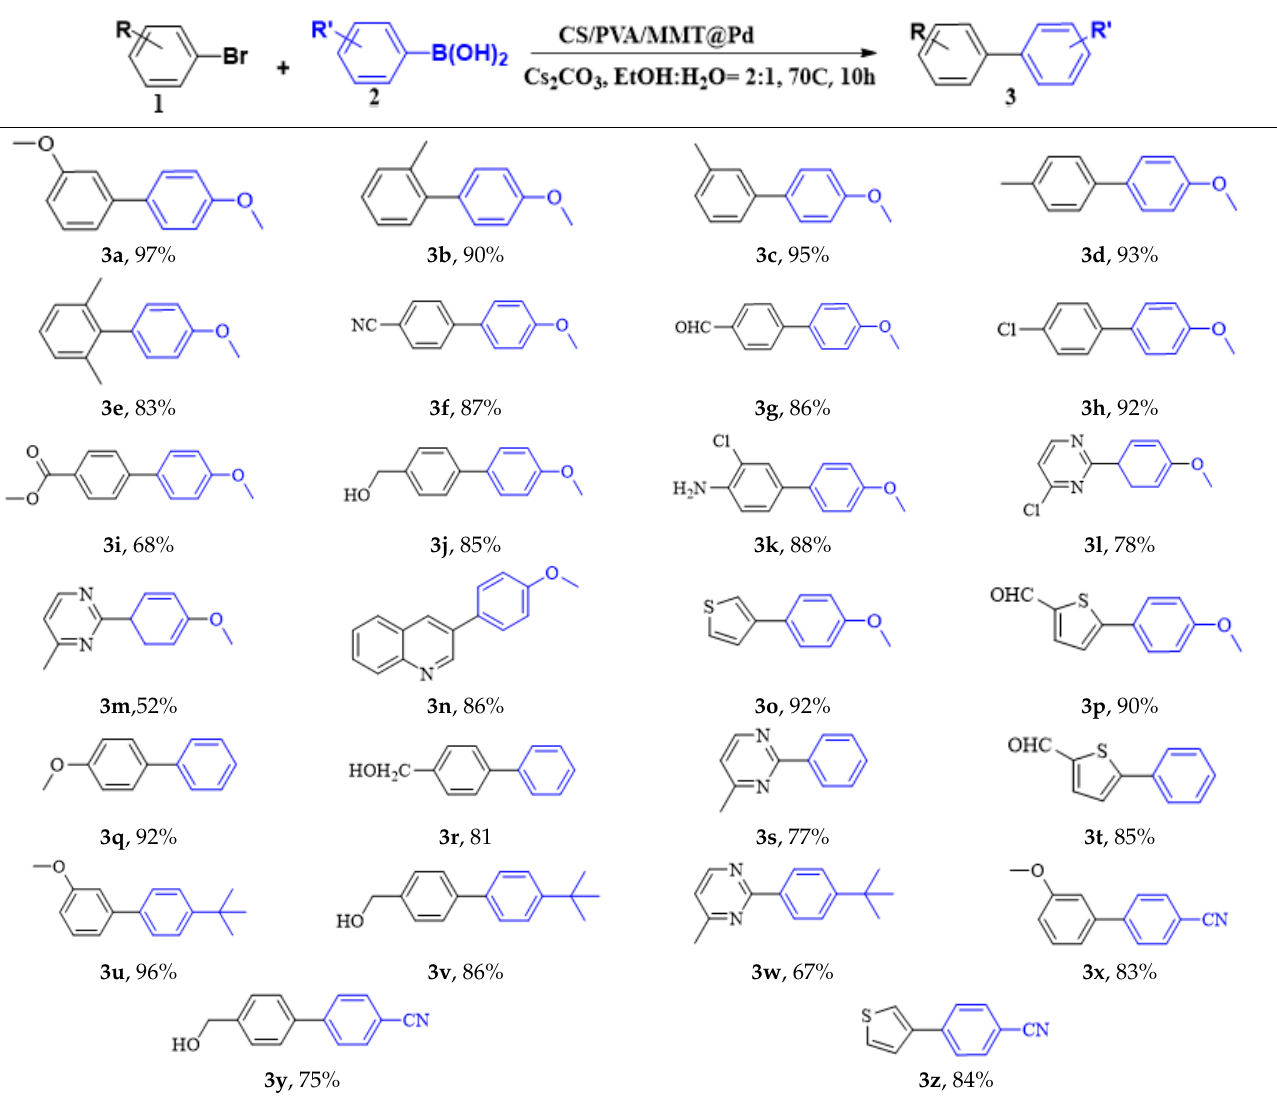
Table 3. Substrate expansion of Suzuki reaction.